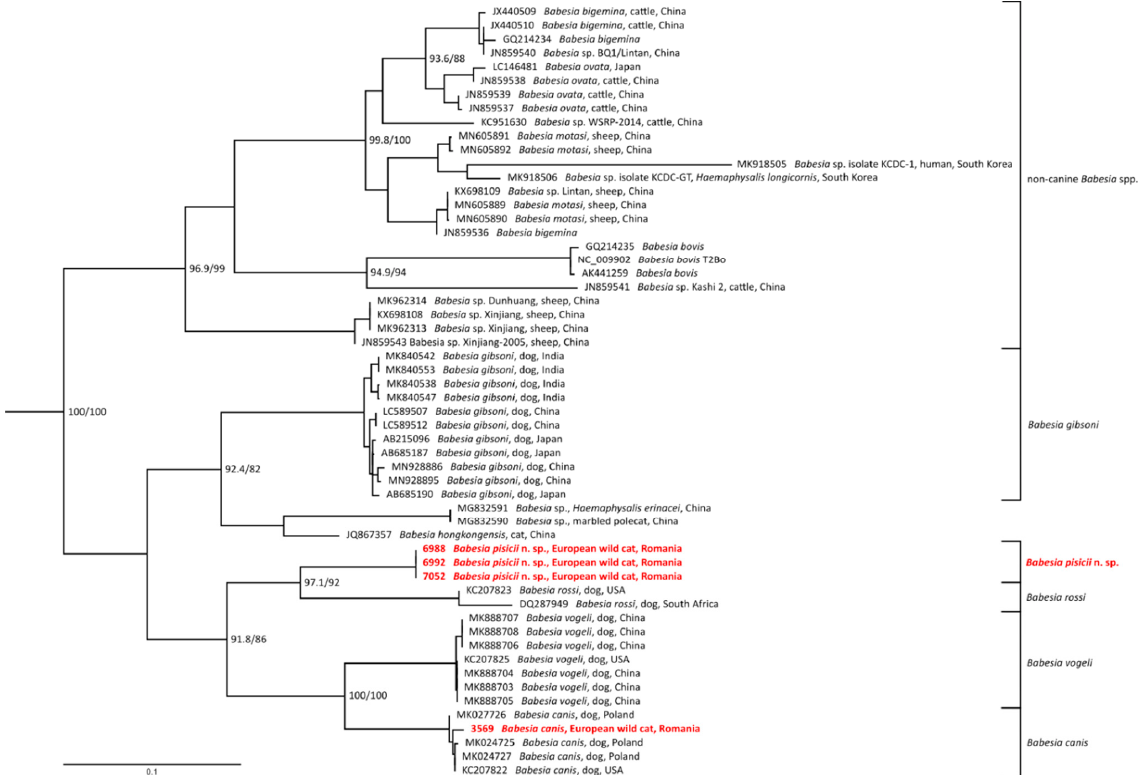
Figure 2. Phylogenetic tree assessed by maximum likelihood method based on Cytb sequences of Babesia sensu stricto species (clade X. sensu Jalovecká et al. [35]) and sequences obtained during the current study (highlighted in red); bootstrap values (SH-aLRT/UFB) above the threshold 80/95 are displayed. The scale bar indicates the number of nucleotide substitutions per site.